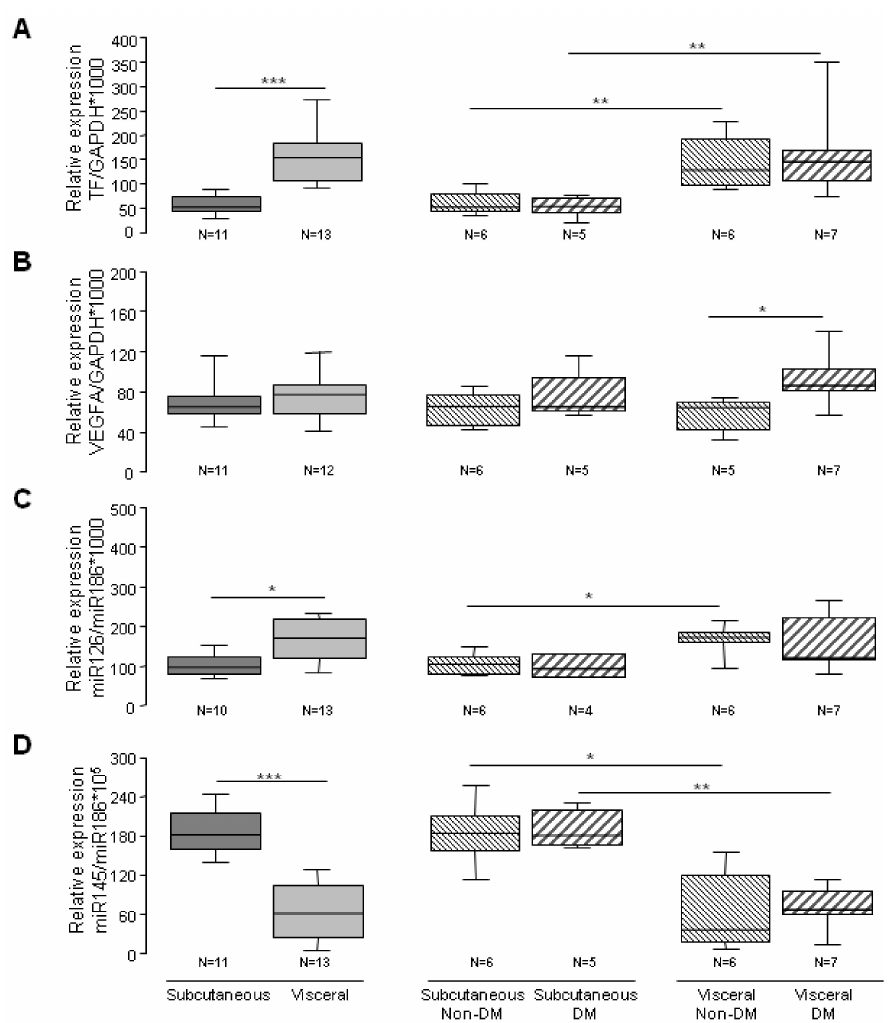
Figure 4. Box-plot diagram showing adipose-derived stem cells (ASCs)-transcriptomic profile. ( A ) Di ff erential mRNA expression of TF in SAT-ASC and VAT-ASC from diabetic with obesity and non-diabetic patients; ( B ) Di ff erential mRNA expression of VEGFA in SAT-ASC and VAT-ASC from obese diabetic and non-diabetic patients; ( C ) Di ff erential miR126 expression in SAT-ASC and VAT-ASC from obese diabetic and non-diabetic patients; ( D ) Di ff erential miR145 expression in SAT-ASC and VAT-ASC from diabetic with obesity and non-diabetic patients. (* p < 0.05; ** p > 0.01; and *** p <